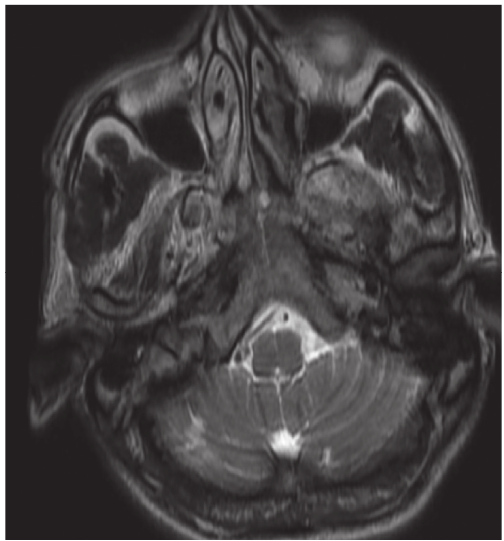
Figure 1: Axial view of MRI brain showing the right cerebellar infarct.